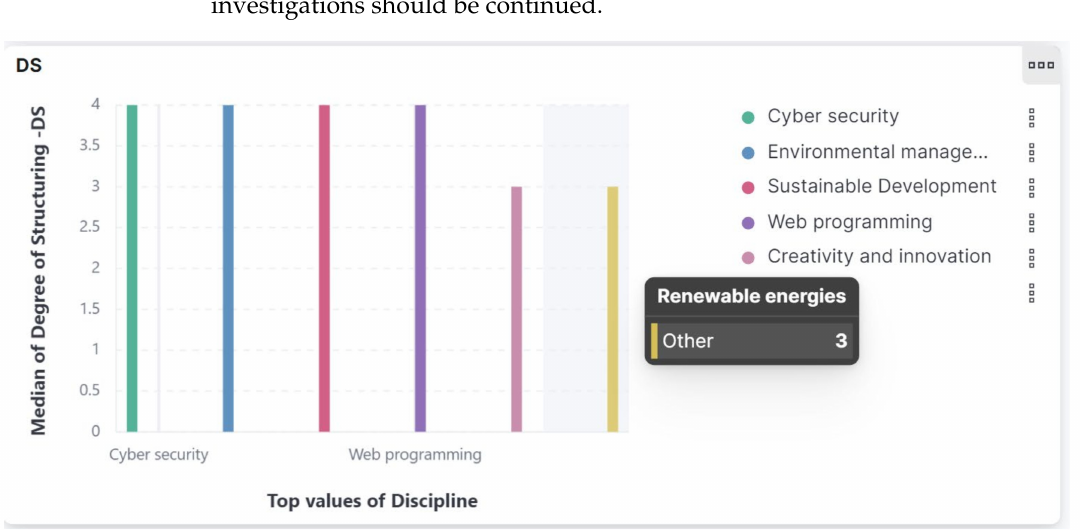
Figure 9. Responsive dashboard presenting Degree of Structuring